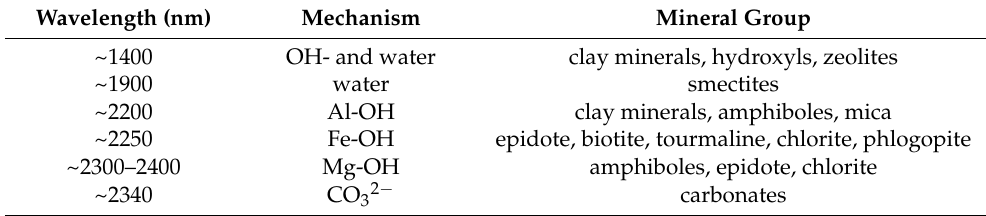
Table 2. Major absorption features [27] of the minerals identified in the present study.